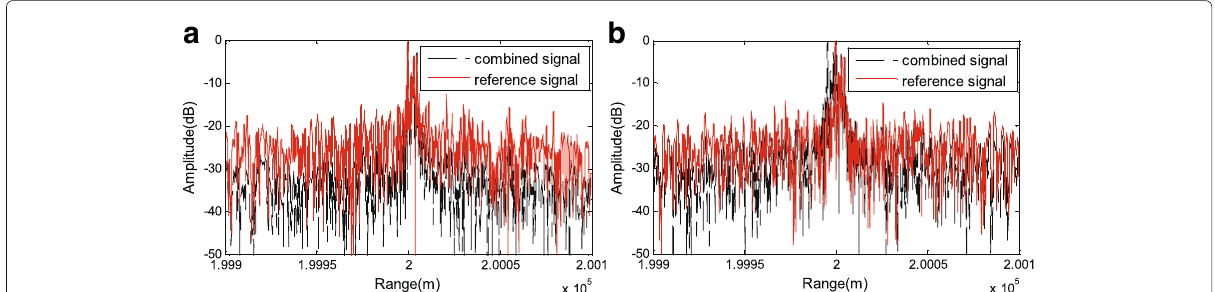
Fig. 7 Comparison between the reference and combined signal. a Dual radar coherent combination realized by RE-CC. b Dual radar coherent combination realized by